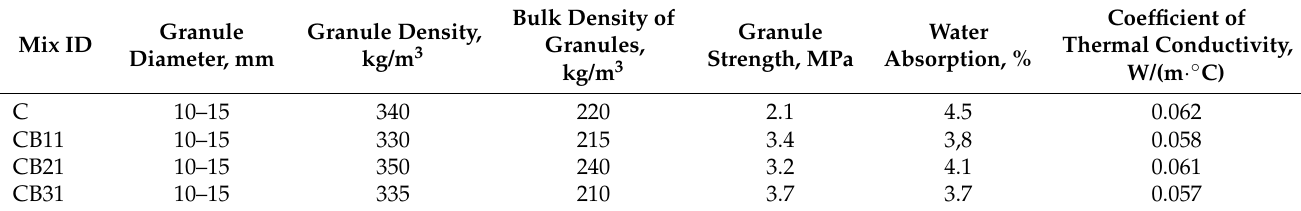
Table 5. Influence of the composition of the molding mixture on the properties of porous granular